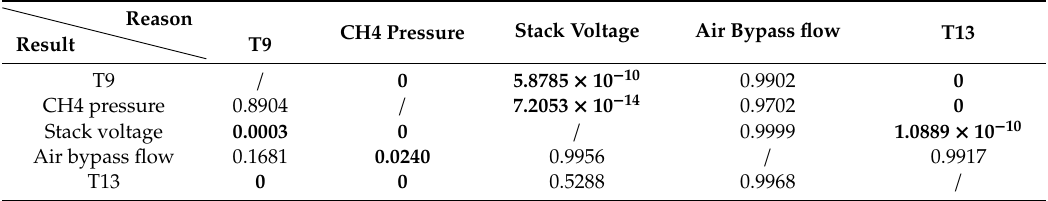
Table 4. P value of the significance